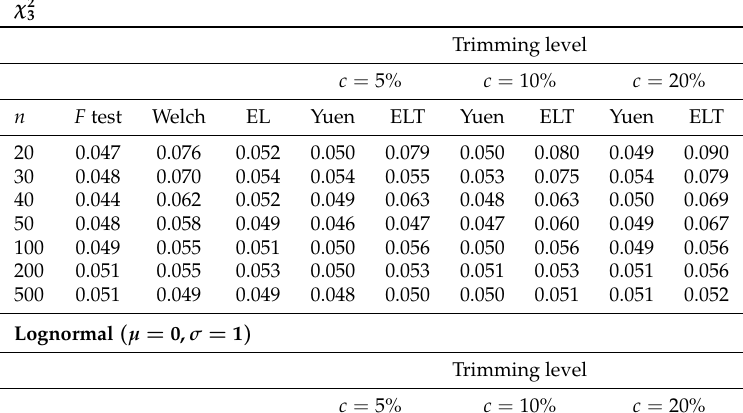
Table 1. Empirical probability of type I error for various tests for the equality of means and trimmed means of three independent skewed distributions with homogeneous variances. For methods involving trimmed means, symmetric trimming at level α i = β i = c , i = 1,2,3 is used. χ 2